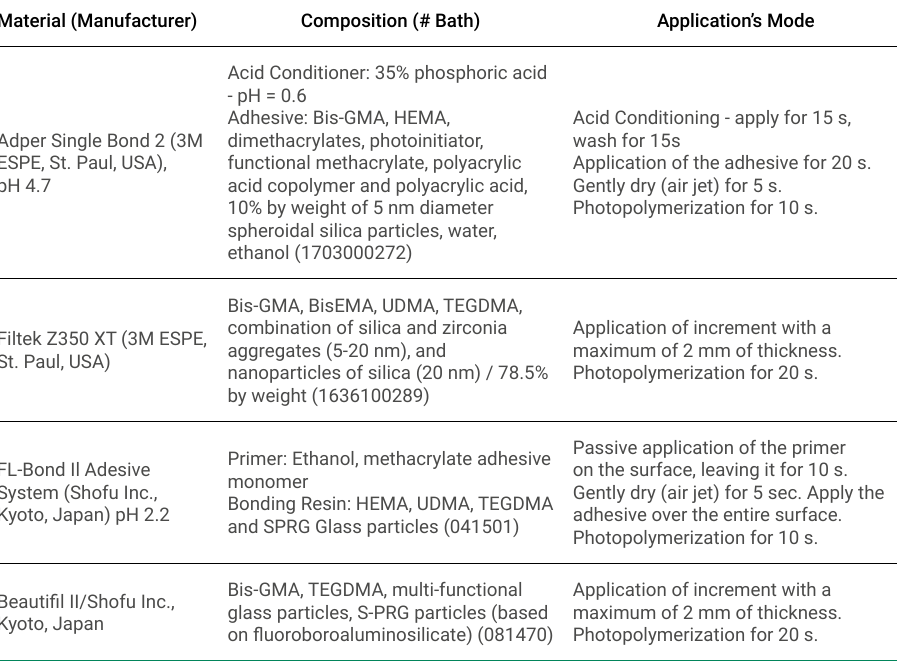
Table 1. Description of the adhesive materials used in the present study (information given by